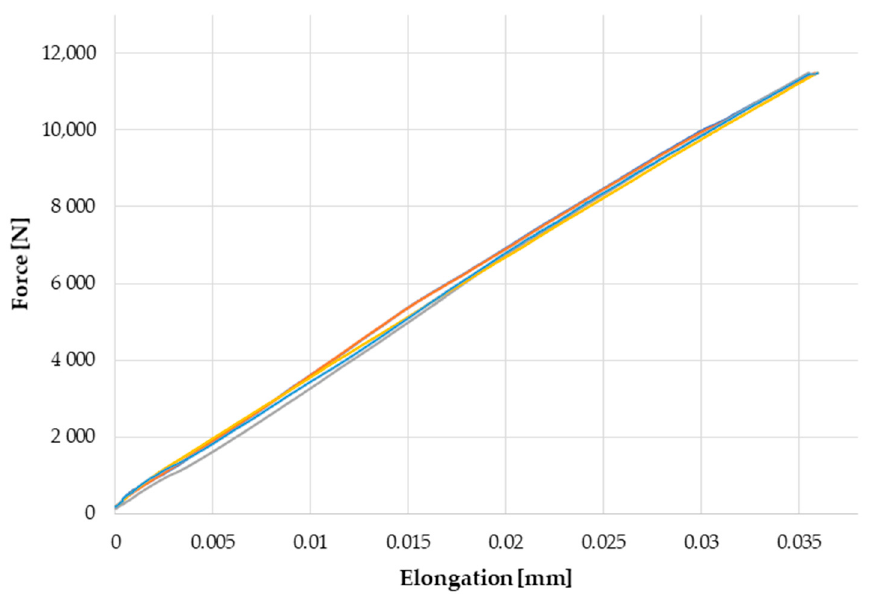
Figure 5. Experimental results of tension test of double overlap sample according to ASTM D3528.